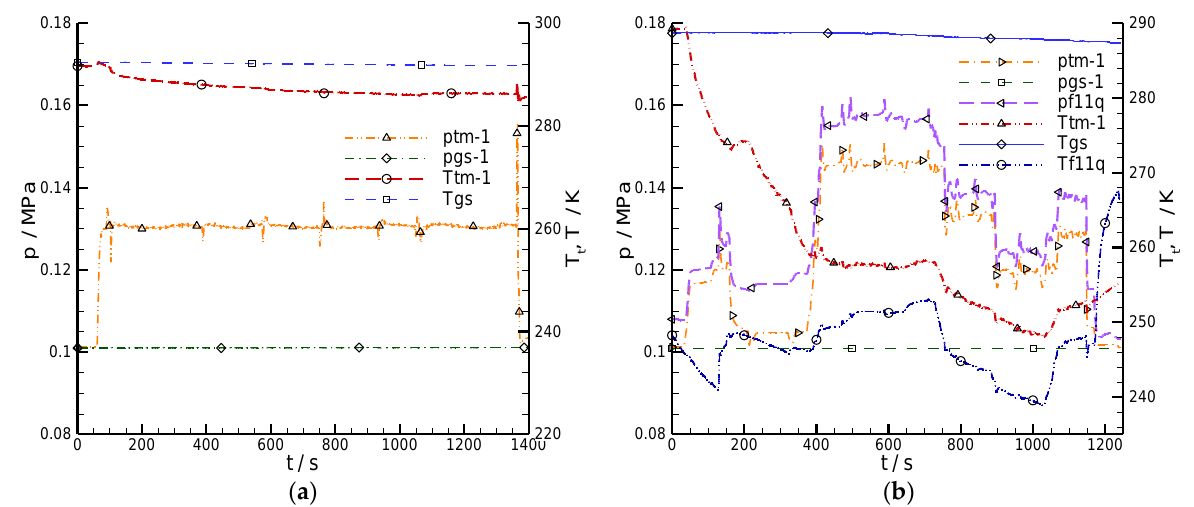
Figure 7. Regulating time sequence of two operating conditions of the core engine test rig main test system. ( a ) Normal- temperature condition; ( b ) low-temperature condition.